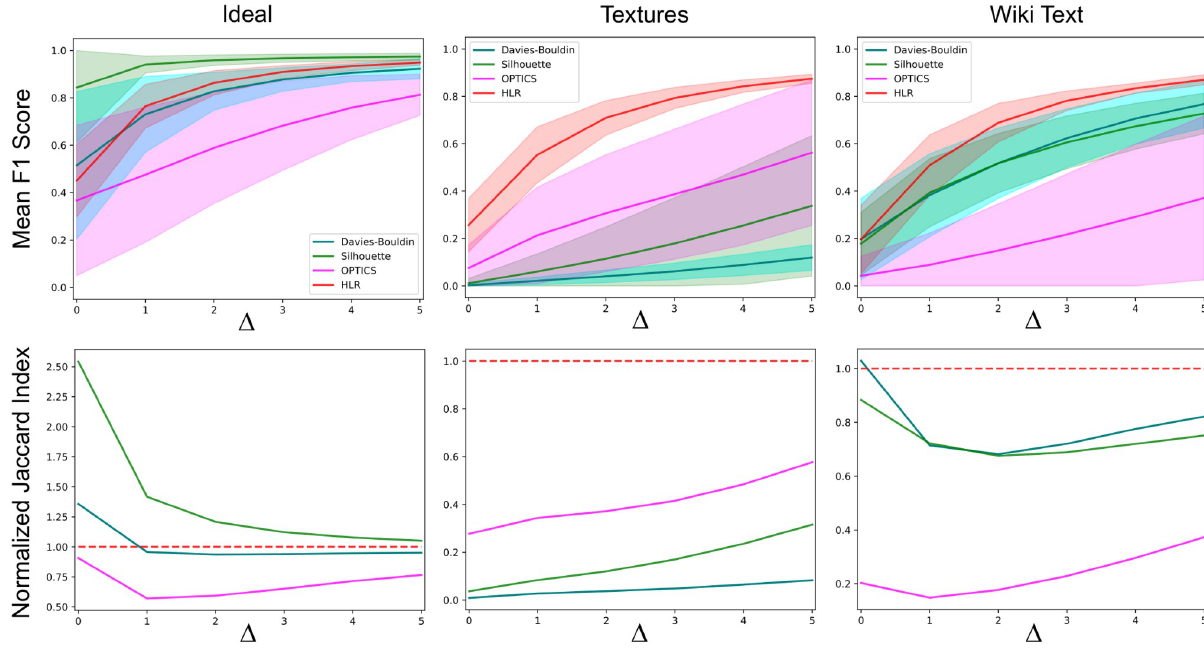
Fig 10. Quantifying performance (mean F1 score and normalized Jaccard index) for multi-cluster number scenario ( ^ y ranging from 1 to 15). Top row: mean F1 score of cluster number estimate being within Δ clusters of the ground-truth, for ideal, image and text data, respectively, testing the best- performing comparator models to hierarchical linkage regression (Davies-Bouldin, Silhouette and OPTICS), as determined from single cluster performance evaluation. Colour shaded regions represent standard deviation of the mean F1 score. Bottom row: mean normalized Jaccard index, corresponding to the same models tested in the multi-cluster number evaluation. The results for the comparators are normalized against the Jaccard index for HLR so that the reference is unity (segmented red line). The results of the F1 score and normalized Jaccard index reveal HLR outperforms its comparators on real-world text and image data, and has lower variance in performance measures, implying greater consistency in its performance across different cluster numbers and cluster deltas.